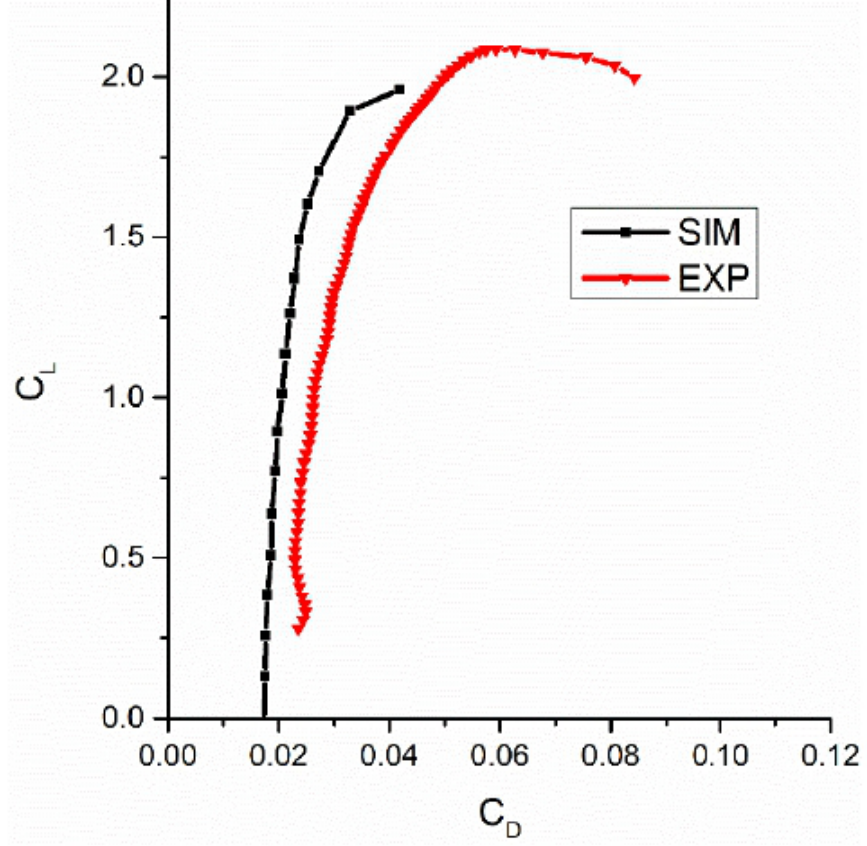
Figure 10. Comparison between the simulation results and experimental results of the polar